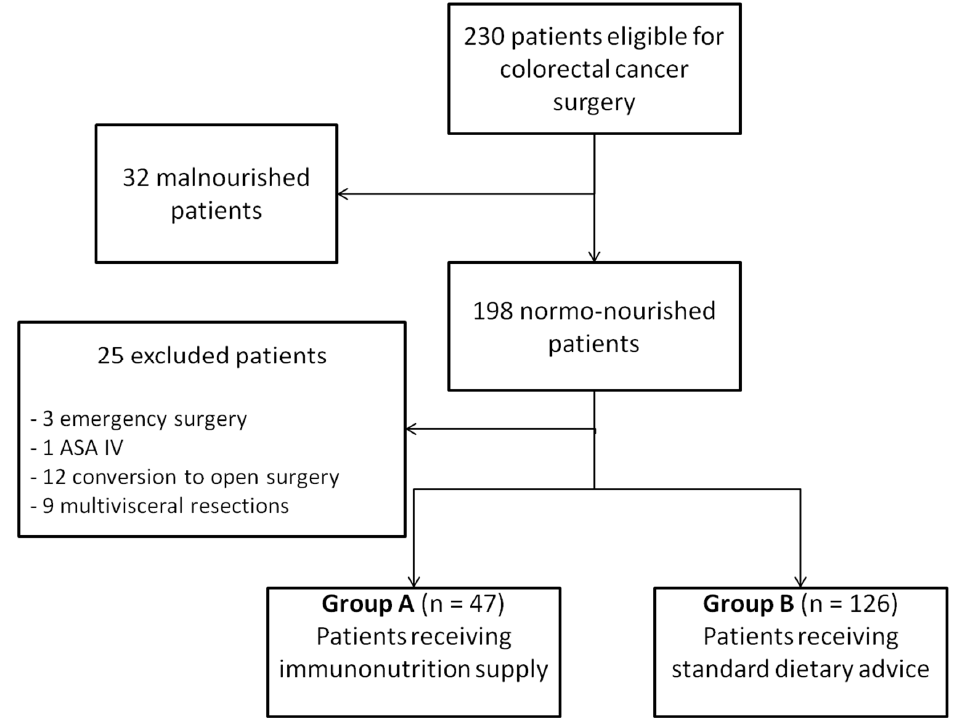
Figure 1. Patients’ selection.